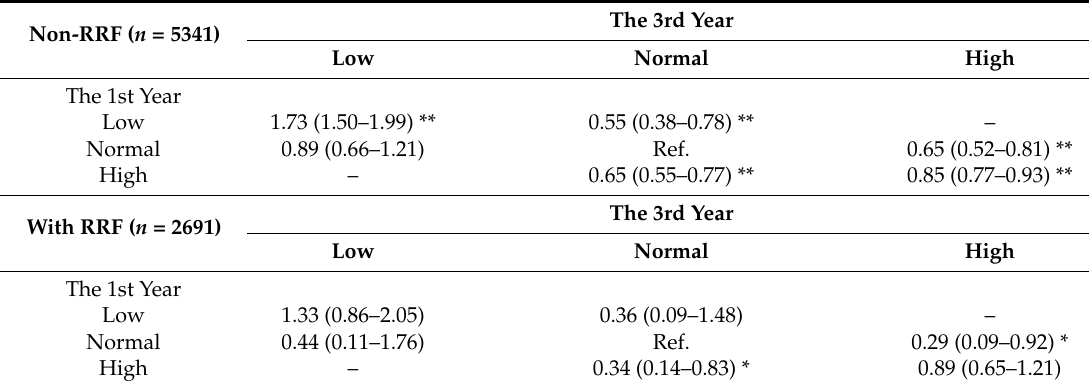
Table 4. Association of Morality and TC groups (low, normal, high) between the 1st and 3rd year